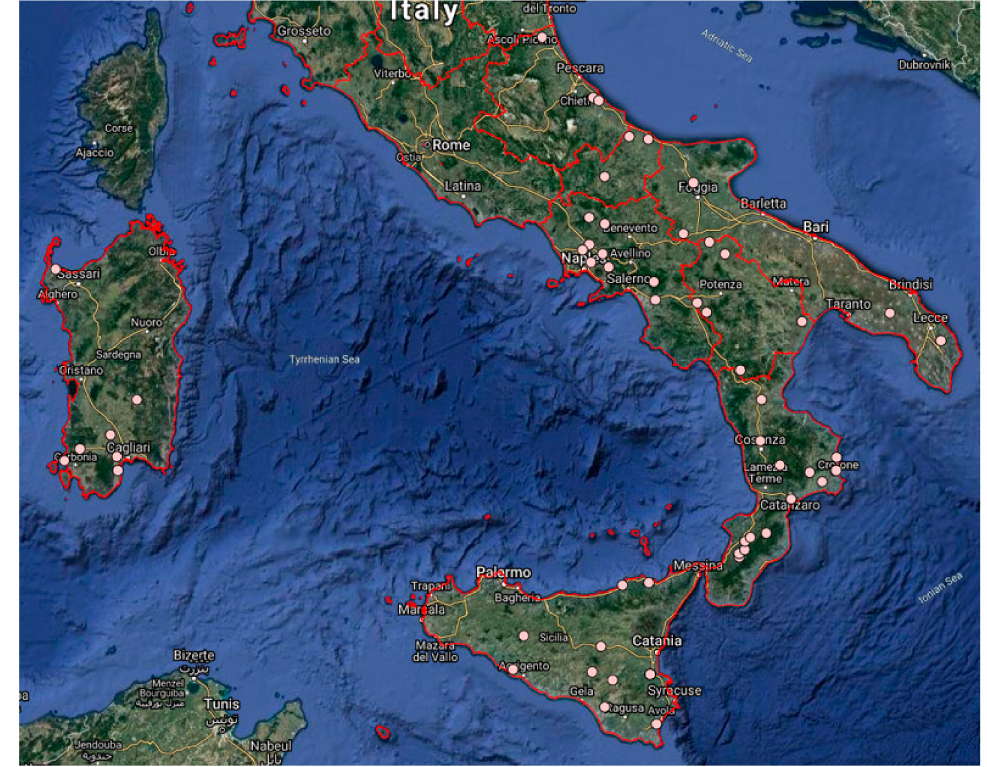
Figure 2. Location of plants for electricity production from solid biomass in Southern Italy (Source: GSE Atlaimpianti